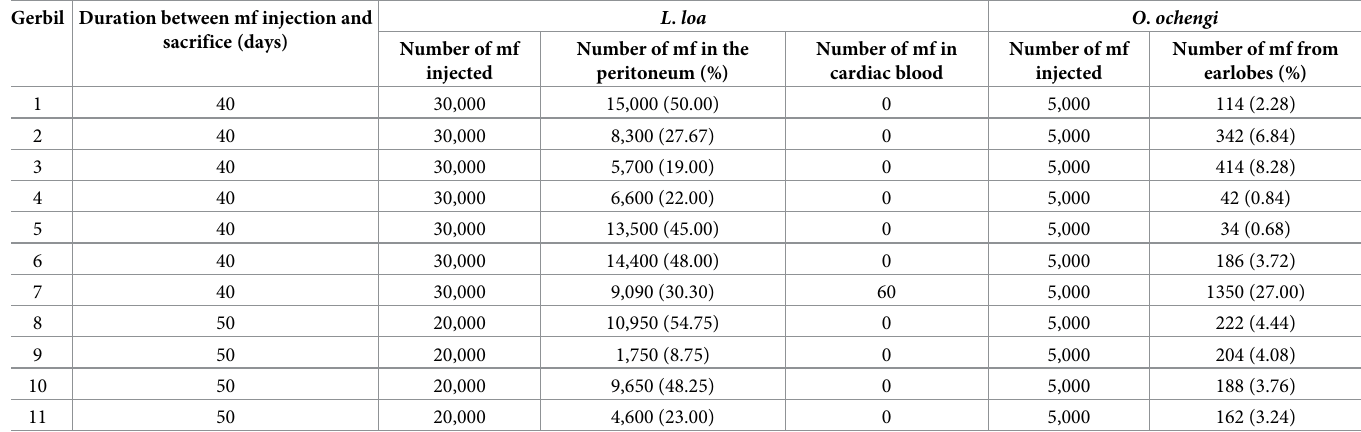
Table 3. Co-injection of gerbils with L . loa and O . ochengi mf for 40 and 50 days. Male and female gerbils were intraperitoneally infected with the 30,000 or 20,000 L . loa mf and one day after, they were subcutaneously infected at the nape with 5,000 O . ochengi mf. Animals were analyzed 40 or 50 days post L . loa mf infection for both mf populations. Gerbil Duration between mf injection and sacrifice (days)